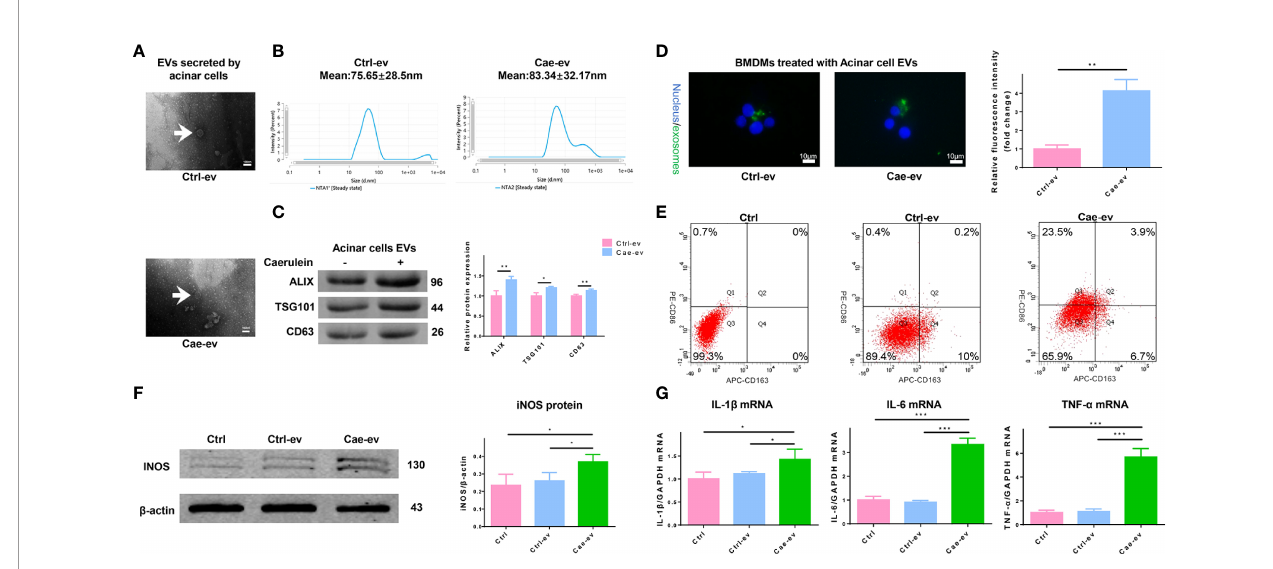
FIGURE 2 | EVs from caerulein-treated ACs promote M1 macrophage polarization. (A) Representative electron micrograph of EVs puri fi ed from AC supernatant from the Ctrl-ev and Cae-ev groups. EVs are indicated by the white arrows. Scale bar, 100 nm. (B) NTA-based determination of the diameter of EVs in the Ctrl-ev and Cae-ev groups. (C) Protein expression and analysis of EV markers (including Alix, TSG101 and CD63) in EVs from ACs treated with or without caerulein by western blotting. (D) Macrophages were treated for 12 h with PKH67-labeled EVs from the Ctrl-ev and Cae-ev groups. The relative fl uorescence intensity was calculated. Scale bar, 10 m m. (E) CD86 (M1 macrophage marker) and CD163 (M2 macrophage marker) expression levels in macrophages treated with Ctrl-ev and Cae-ev were detected by fl ow cytometry. (F) Protein expression and analysis of iNOS in macrophages treated with EVs from PBS-treated ACs and caerulein-treated ACs using western blotting. (G) In fl ammatory cytokine mRNA expression (IL-1 b , IL-6 and TNF- a ) in macrophages was detected by qRT-PCR. Data are presented as the mean ± SD. All experiments were repeated three times. * p <0.05, ** p <0.01, *** p <0.001. NTA: nanoparticle tracking analysis, Ctrl-ev: EVs derived from PBS- treated acinar cells, Cae-ev: EVs derived from caerulein-treated acinar